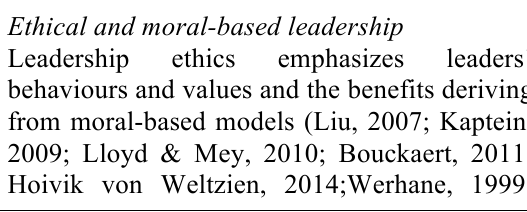
Table 1: Theoretical Constructs of Leaderships for CSR and Leaders’ Attributes Ethical and moral-based leadership Leadership ethics emphasizes leaders’ Leaders with moral/behavioral